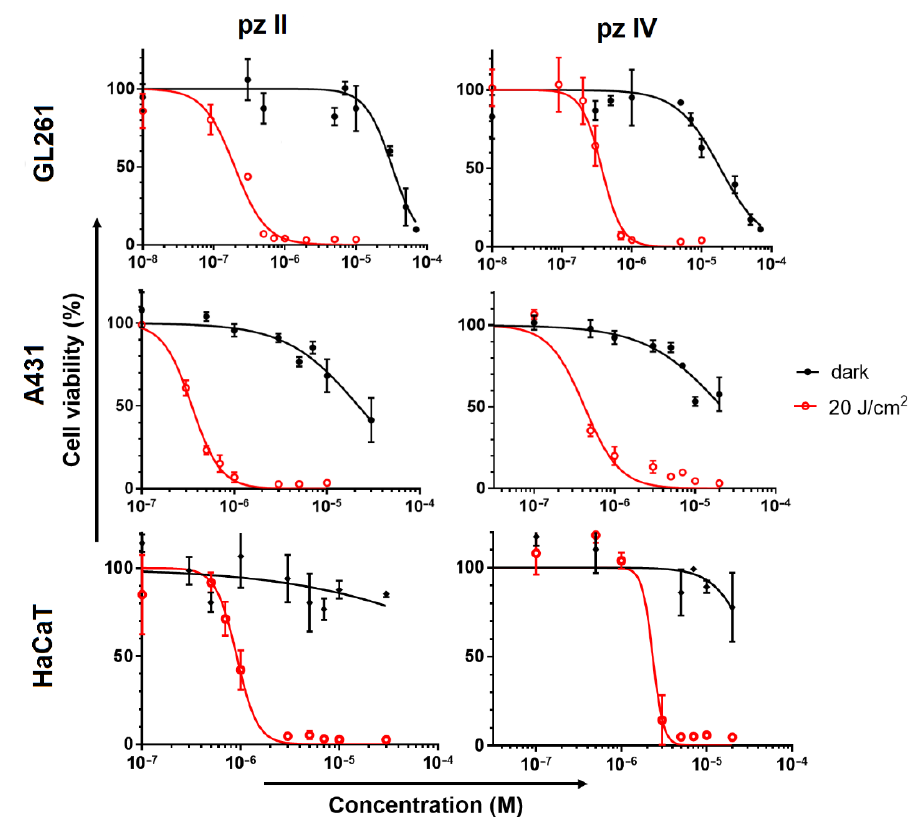
Figure 9. Dark toxicity and photodynamic activity of pz II and pz IV against murine glioma GL261, human epidermoid carcinoma A431 and human keratinocytes HaCaT cells. The cells were incubated with pz in serum-free medium for 4 h and then exposed to light irradiation ( λ ex 615–635 nm, 20 J/cm 2 ) or stayed in the dark for the same time interval. After 24 h, the cell viability was analyzed by MTT assay. The representative dose – response curves from three independent experiments (each in triplicate) are shown. The data represent the mean values ± SD (n = 3).